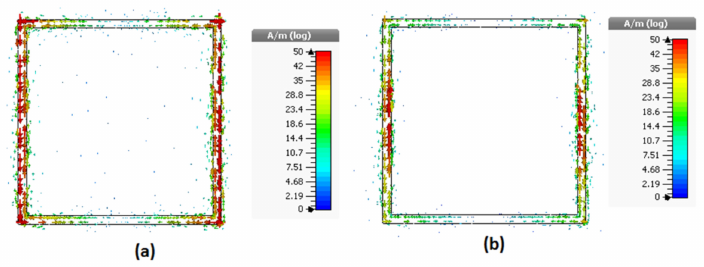
Figure 9. Current distribution of AMC structure ( a ) at 2.45 GHz and ( b ) at 4.8